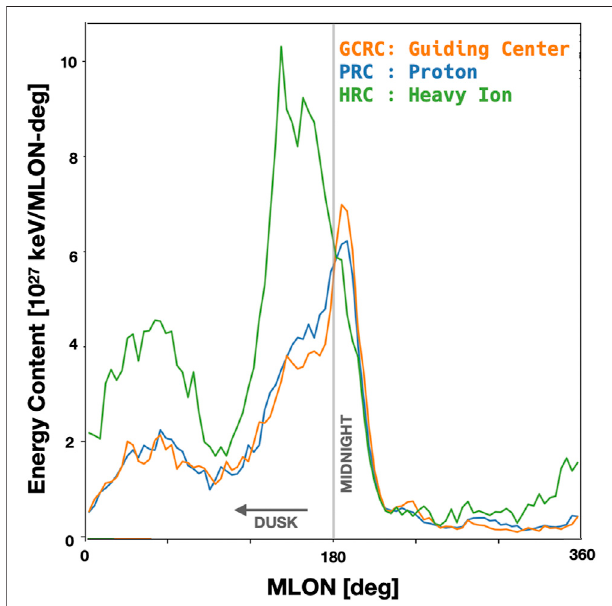
FIGURE 7 | Comparison of the magnetic longitude distribution of total energy content, within R (cid:2) 12 at T (cid:2) 0, for identical test particle ensembles evolved with increasing